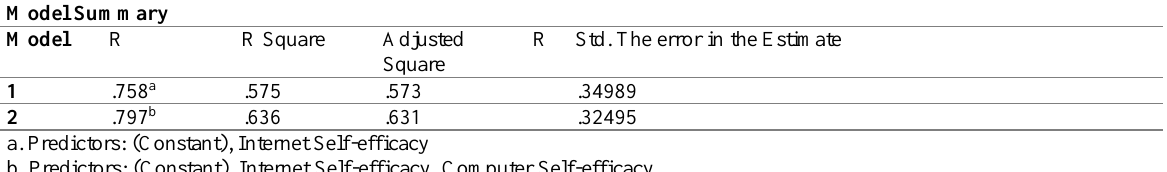
Table 4: The relationship between computer, internet self-efficacy and job satisfaction of the employees of Divine Word College of